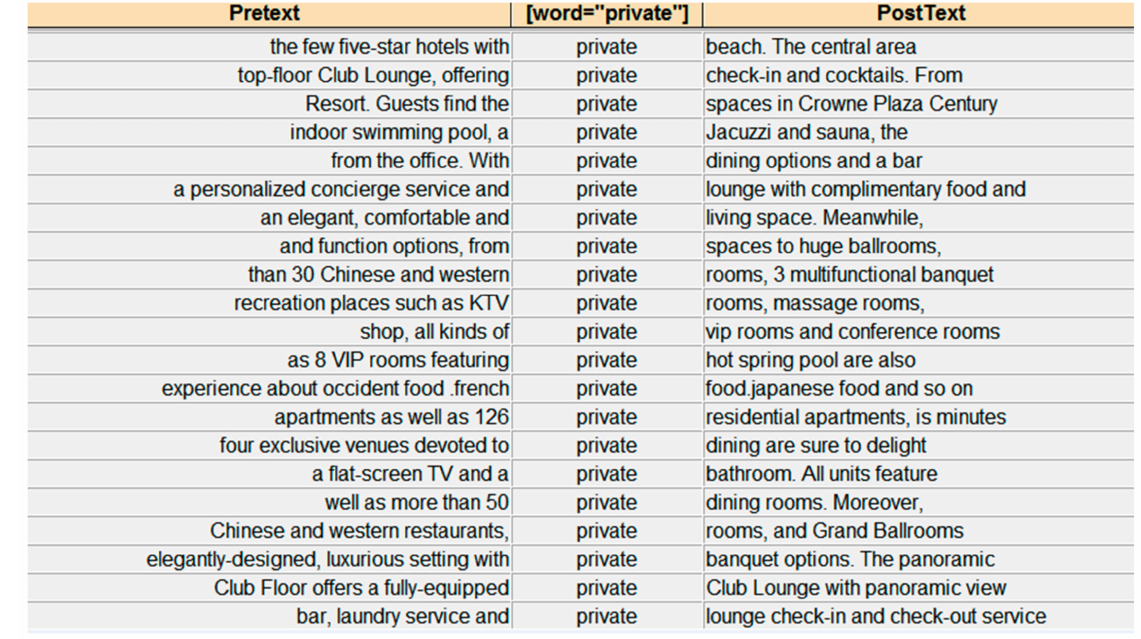
Figure 3. Examples of the use of “private” in